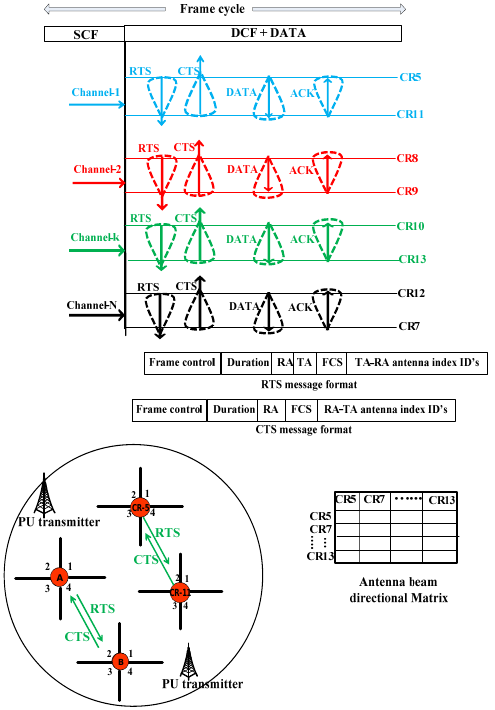
Figure 6. Random access based cognitive DCF